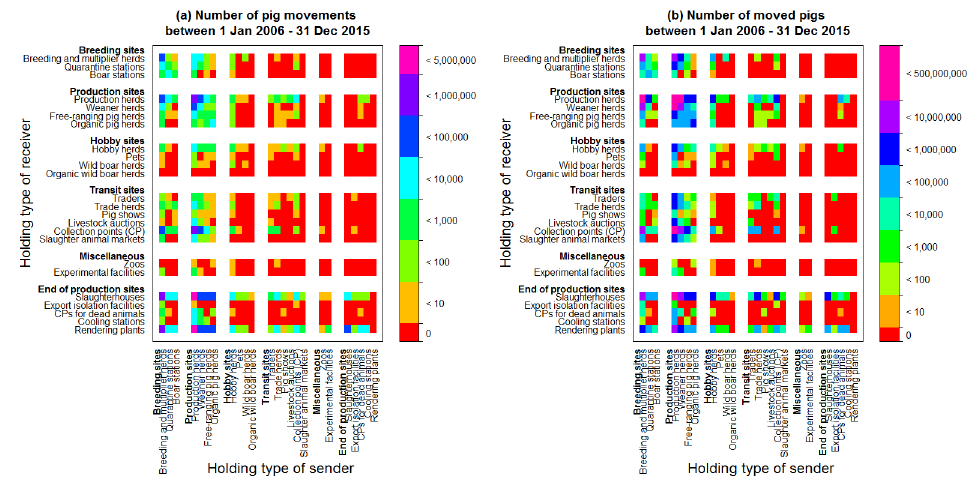
Fig 3. Registered pig movements and number of pigs moved. Heat maps describing (a) the numberof registeredpig movements and (b) the number of pigs moved betweenholdingtypes from 1 st January2006 and 31 st December2015 in Denmark. The heat maps show stability over time and for the number of movements (data not shown).